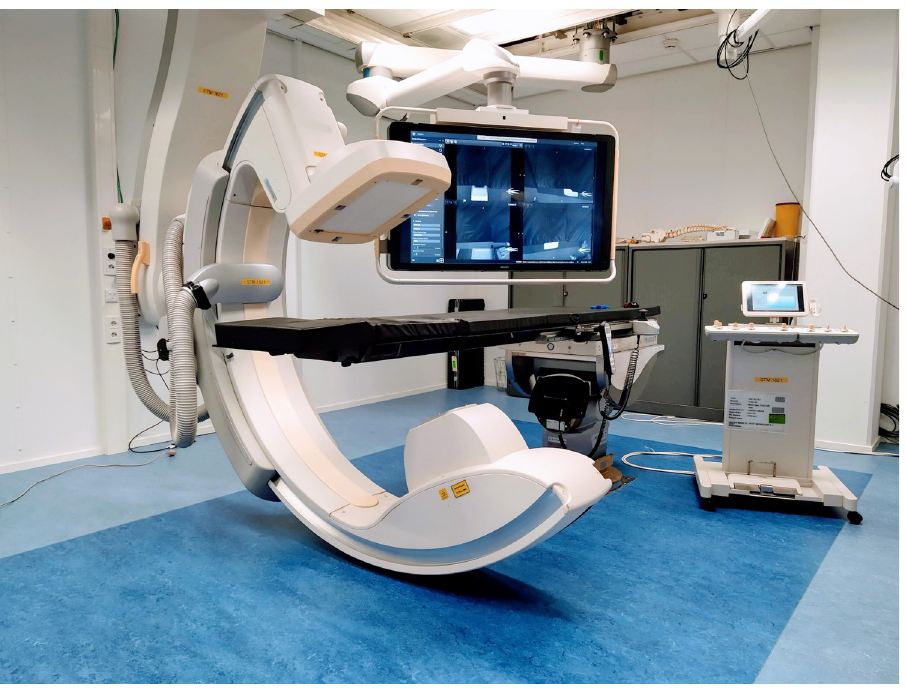
Fig 1. Augmented reality surgical navigation system for endoscopy.